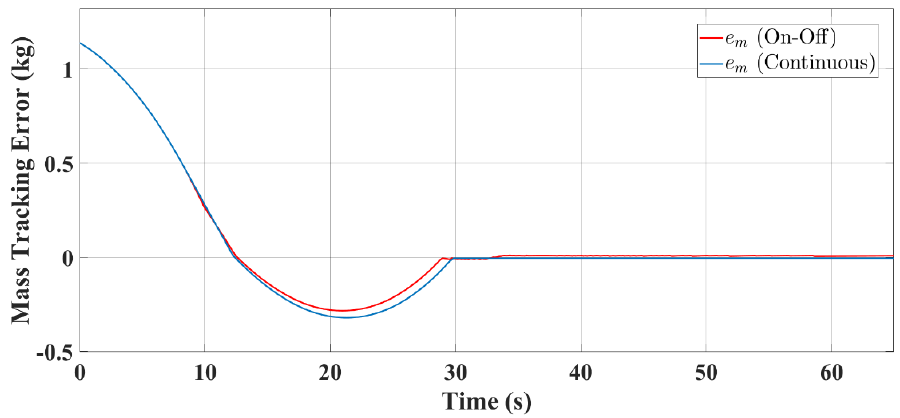
Figure 7. Ballast mass tracking errors of on-off and continuous type VBS control.